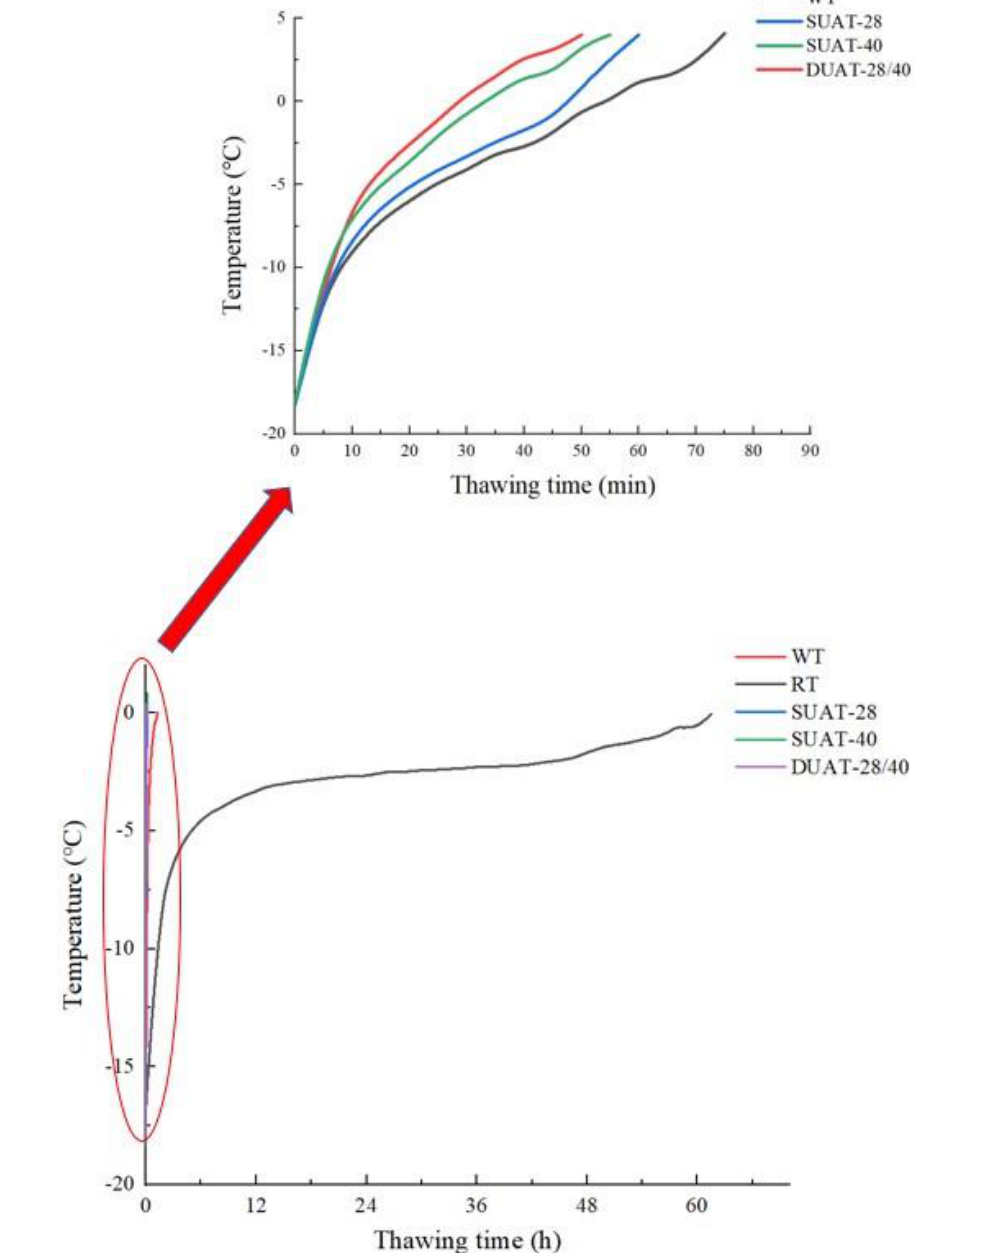
Figure 2. Differences in thawing curve of large yellow croaker under different thawing methods. (WT: water thawing; RT: refrigerated thawing; SUAT-28: single-frequency ultrasound-assisted thawing at 28 kHz; SUAT-40: single-frequency ultrasound-assisted thawing at 40 kHz; DUAT-28/40: dual-frequency ultrasound-assisted thawing at 28 kHz and 40 kHz).